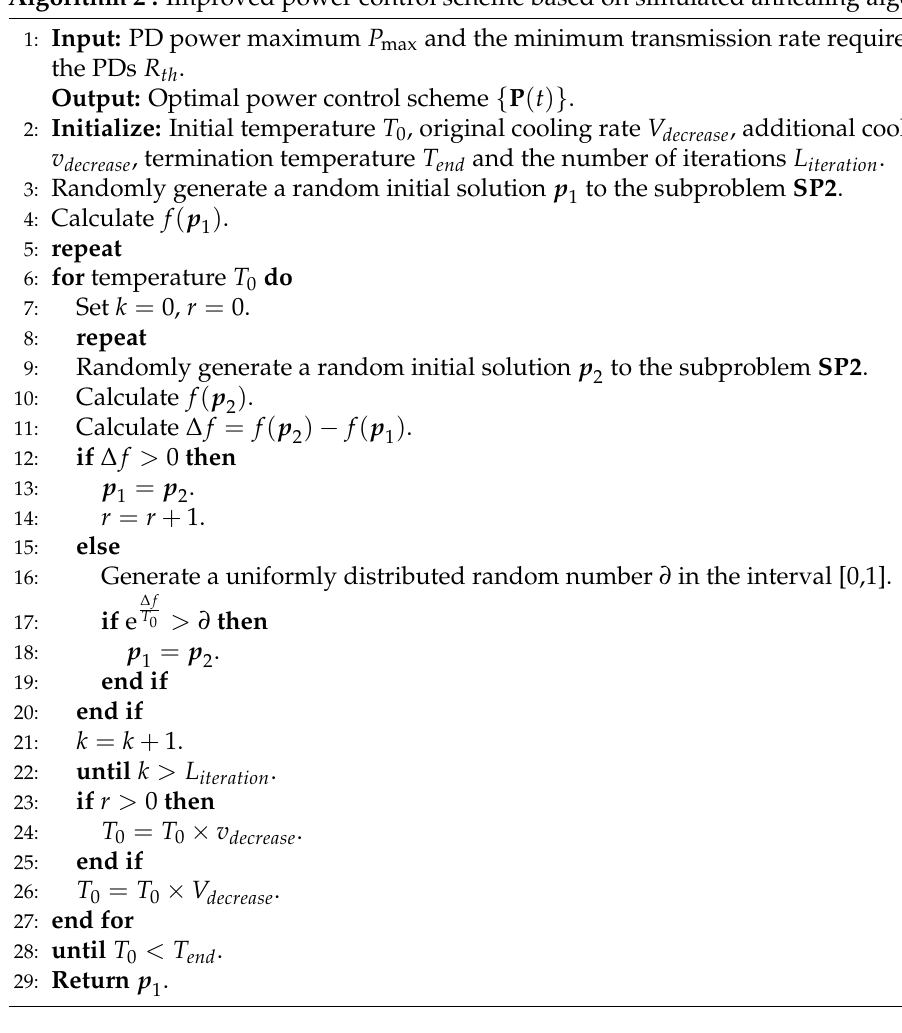
Algorithm 2 : Improved power control scheme based on simulated annealing